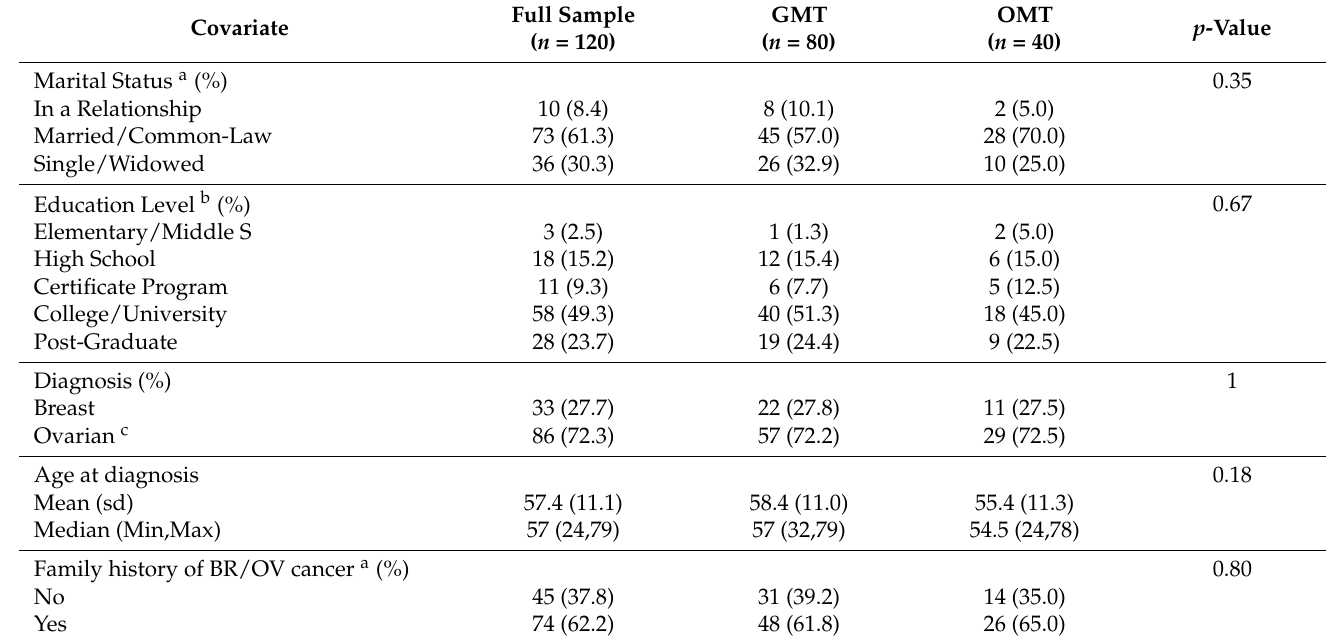
Figure 1. Study Design and Participation. OMT: Oncologist-mediated Genetic Testing; GMT: Genetic Counselor-mediated Genetic Testing. * five individuals (two OMT and three GMT) completed survey 1 after receiving their genetic test results and were excluded from analysis. Table 1. Comparison of participant demographics in GMT versus OMT cohorts.